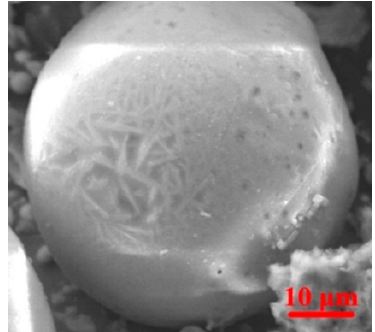
Figure 2. Figure 5 Equivalent circuit: ( a ) real impedance of UWB antenna; ( b ) comparison of reflection coe ffi cients. Figure 4. Scanning electron microscope (SEM) image of the glass sphere containing mullite in FA-1.